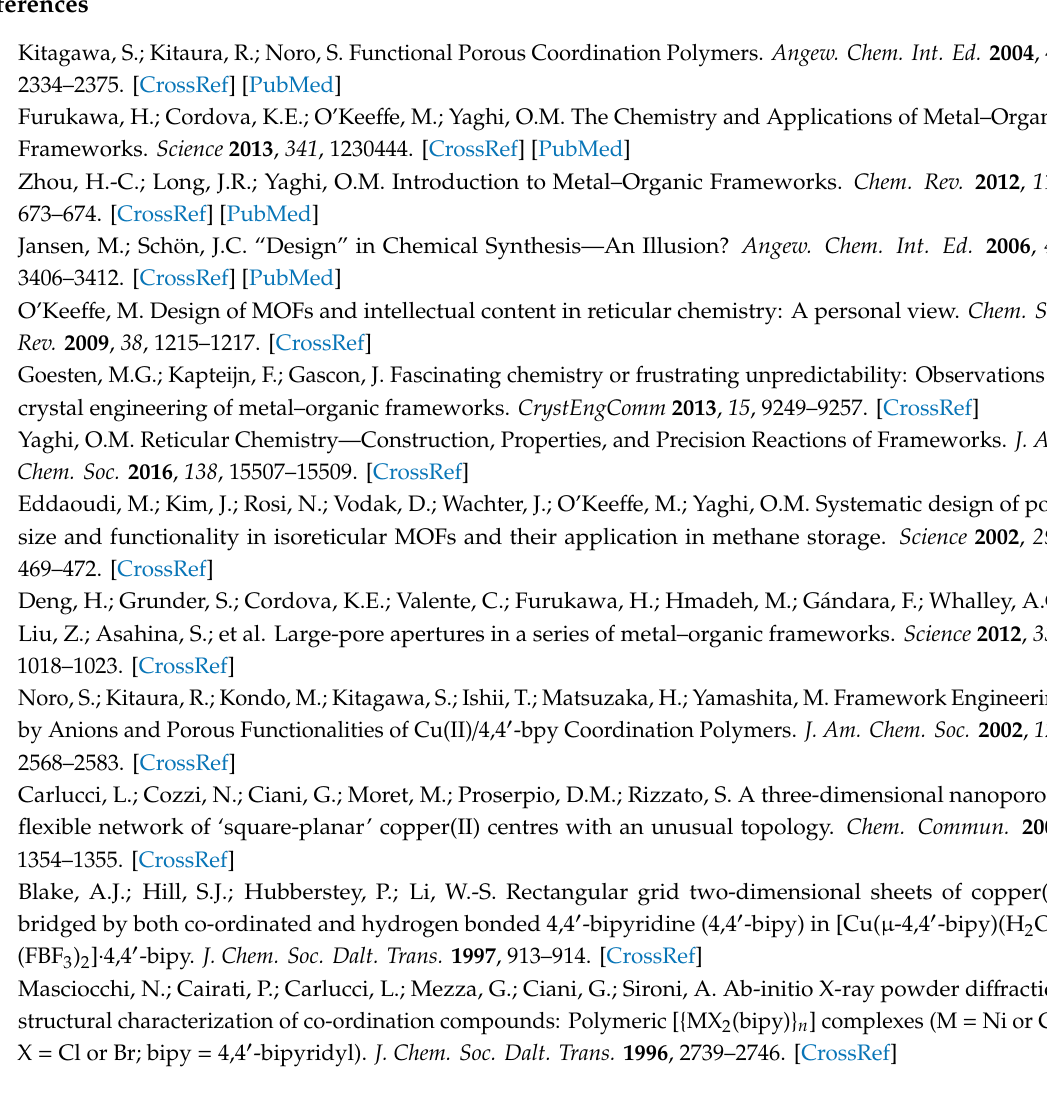
Figure S1: PXRD patterns; CIF and checkCIF files of the crystal structures, and twin logout for CP 3